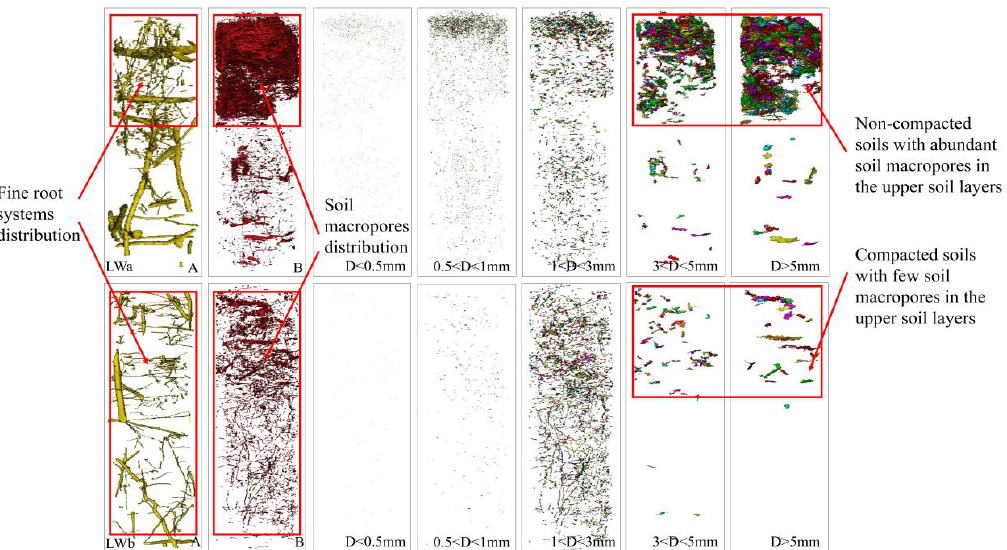
Figure 5. Three-dimensional structure of the root and macropore networks at LWa and LWb (A represents the 3D structure of root systems, B represents the 3D structure of soil macropores, and D represents equivalent diameter).